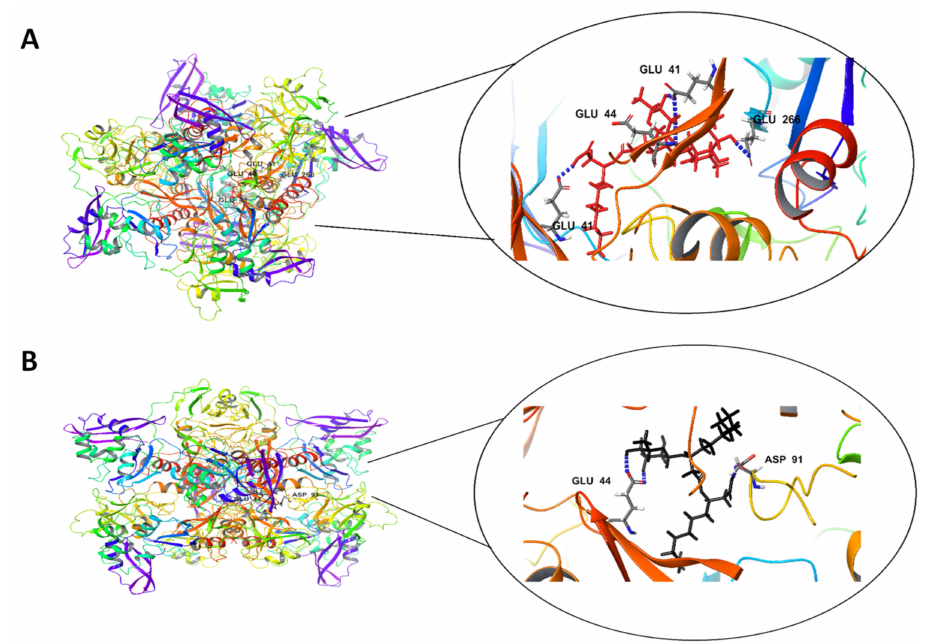
Figure 4. In silico docking study revealing interactions between ( A ) Rha(s)1 and ( B ) Rha(s)2 with the active sites of SARS-CoV-2 EndoRNAse. PDB accession number for EndoRNAse is